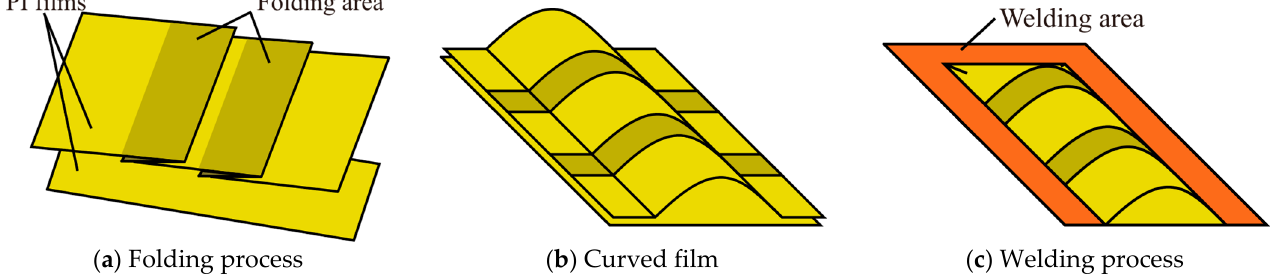
Figure 12. Fabrication method of bellows structure; ( a ) folding films; ( b ) bending upper film for welding; ( c ) welding of three sides.